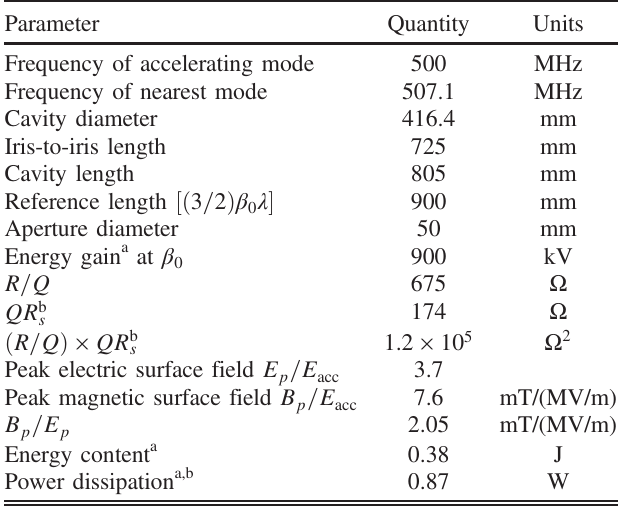
TABLE IX. Cavity and rf properties of double-spoke